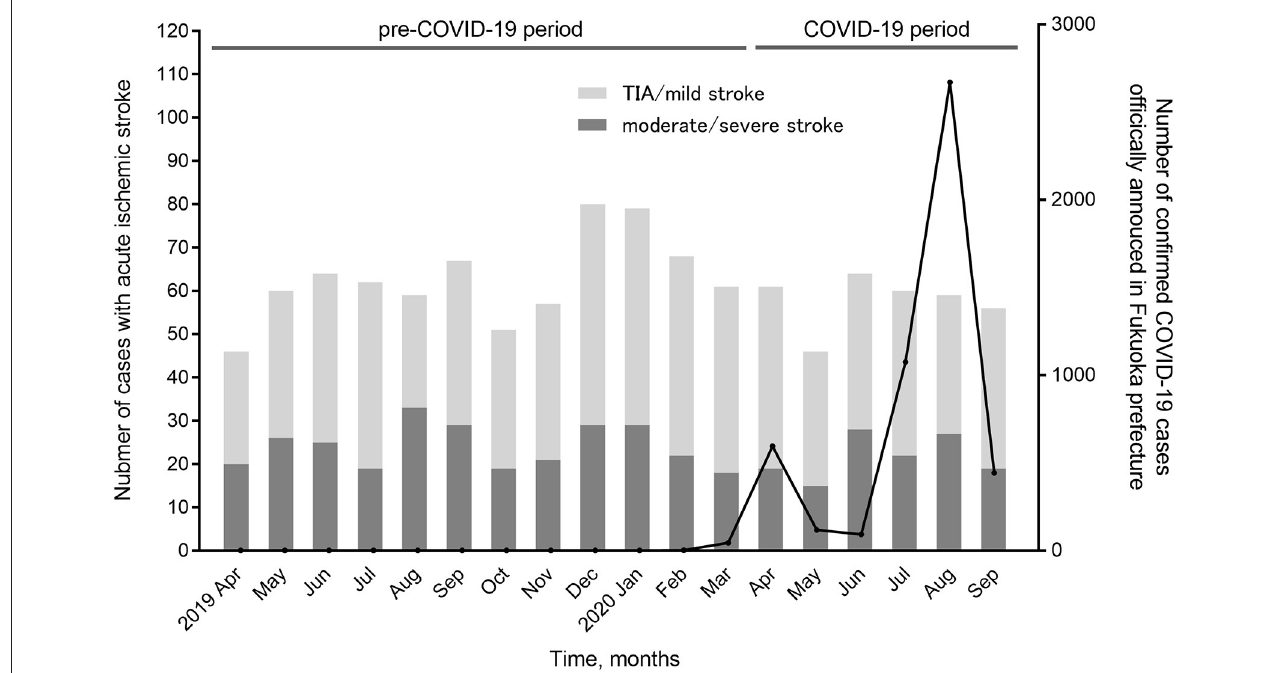
FIGURE 1 | Monthly proportions of patients with transient ischemic attack/mild stroke among overall acute ischemic stroke cases. No significant trend in the proportion of transient ischemic attack (TIA)/mild stroke among overall acute ischemic stroke cases was seen during the study period ( p = 0.231, Cochran-Armitage trend